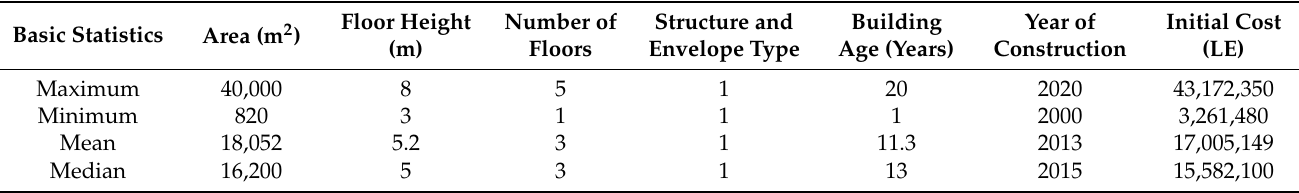
Table 3. The basic statistical information about the data collection